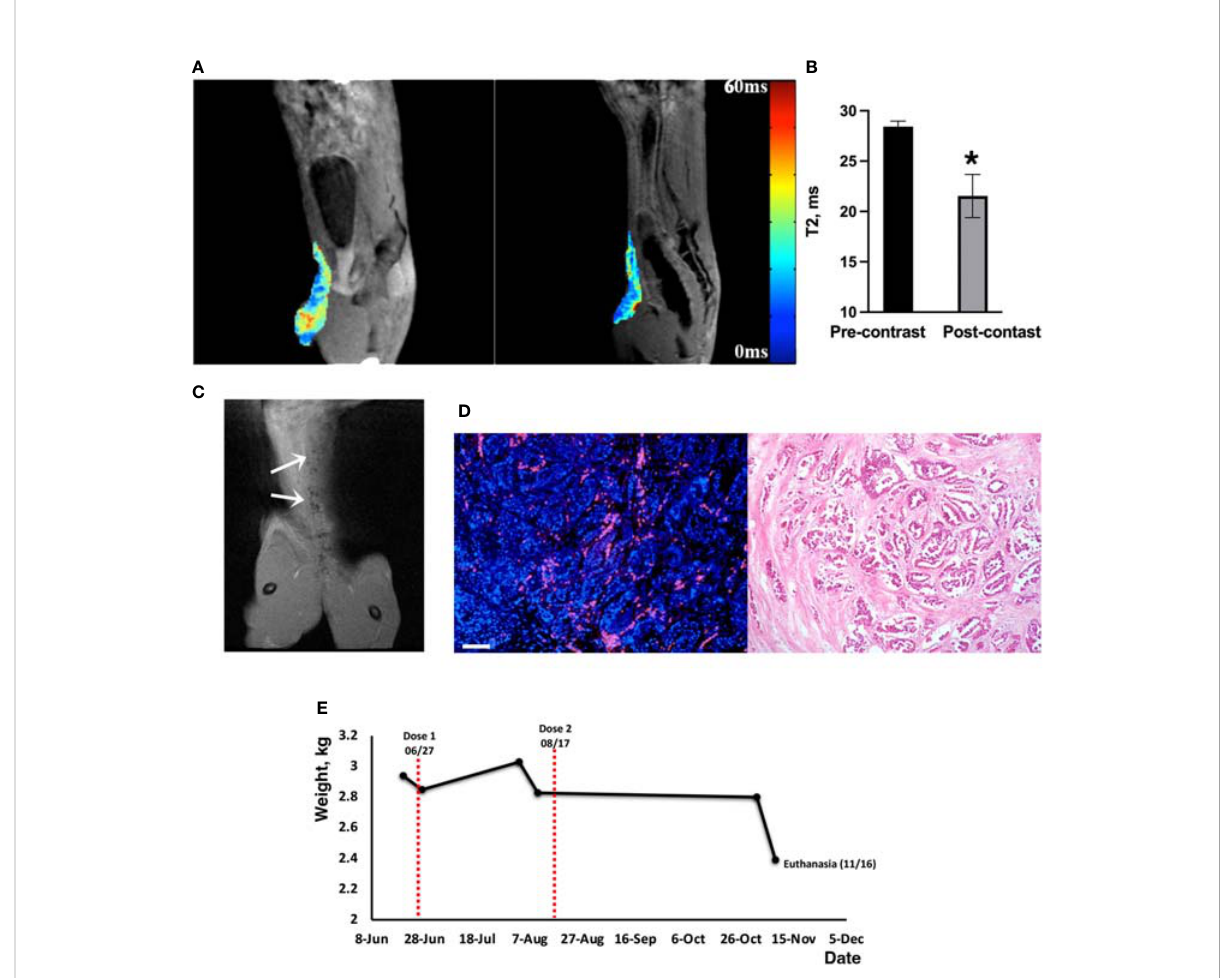
FIGURE 3 MRI of MN-anti-miR10b delivery to metastatic breast cancer in a feline patient. (A) Pre-contrast and post-contrast T2* images (sagittal) of Cat 0 injected with one dose of MN-anti-miR10b. There was a notable loss in signal intensity over the secondary mammary lesion after injection of the therapeutic. (B) Quantitative analysis of relaxation times (T2 pre – T2 post, ms) of the tissues, con fi rming accumulation of MN-anti-miR10b (n=8, p<0.04). Data are represented as mean ± s.d. (C) Coronal post-contrast T2-weighted image showing signal voids identi fi ed by MN-anti- miR10b (arrows) corresponding to lesions in the abdominal area. (D) Left: Fluorescence microscopy showing accumulation of MN-anti-miR10b in the lesion (red – Cy5.5 on the nanoparticle; blue- DAPI); Right: H&E staining of the consecutive slice. Scale bar =100µm. (E) Animal weight during the course of the experiment. This symbol * means that the data are statistically signi fi cant (i.e.,